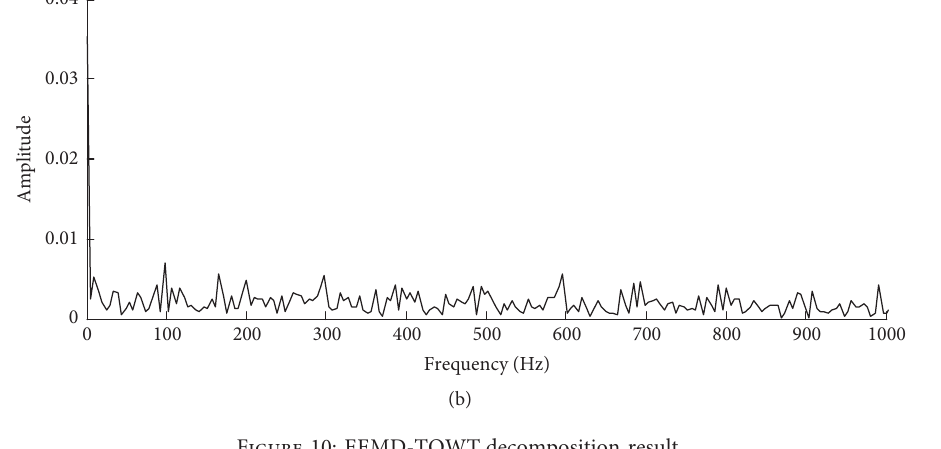
Figure 10: EEMD-TQWT decomposition result.